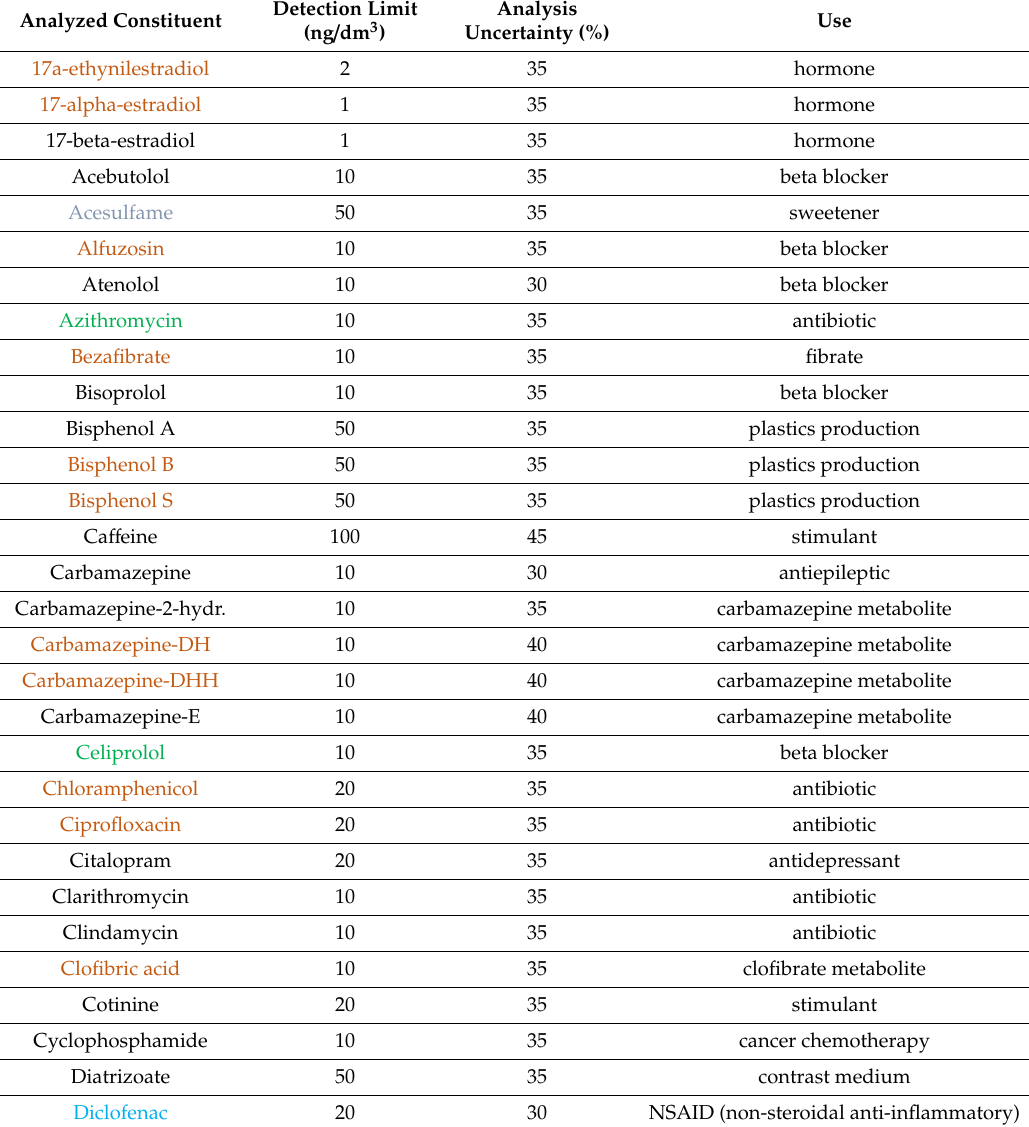
Table 1. List of analyzed pharmaceuticals and personal care products (PPCP) constituents monitored in 2017–2018. Marked in blue are the nine substances selected for water monitoring evaluation between 2017 and 2018, and in green the seven other substances deliberated additionally in the 2019 part of wastewater monitoring. Substances with concentration mostly below the detection limit (95–100% of samples) are marked in